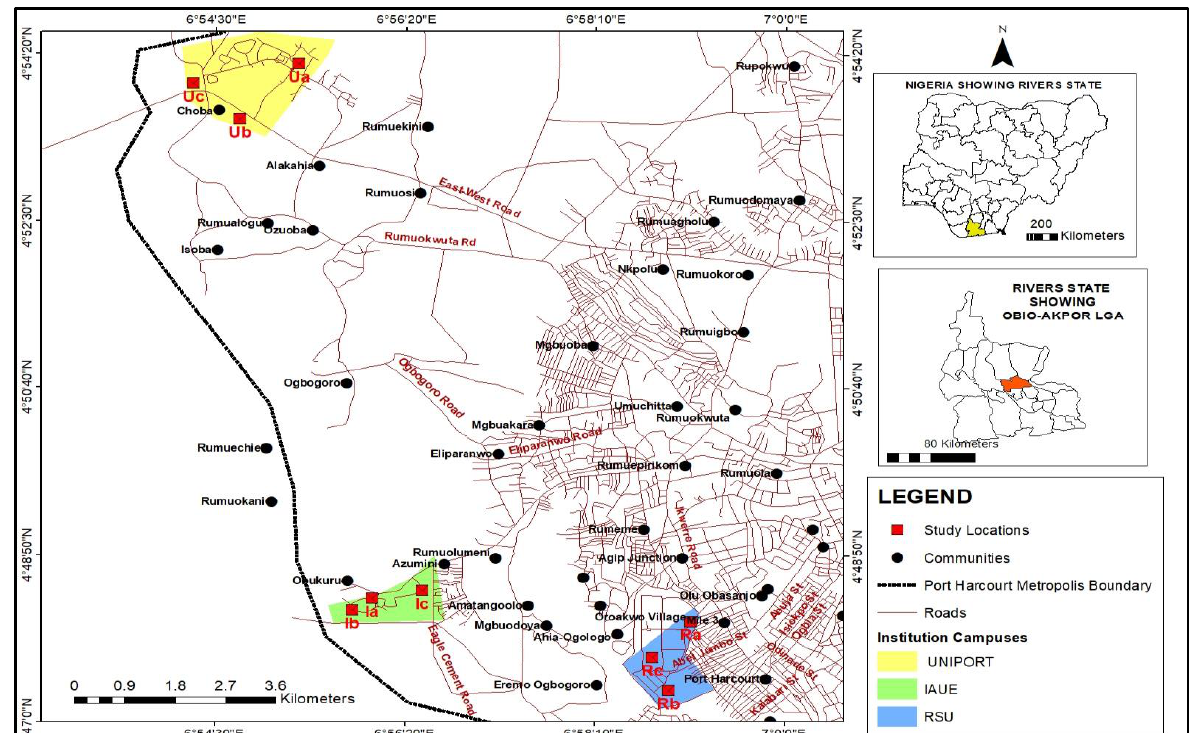
Figure 1. Map of the study locations, I, R, and U (source: Digitized from Ministry of Lands/Survey, Port Harcourt).